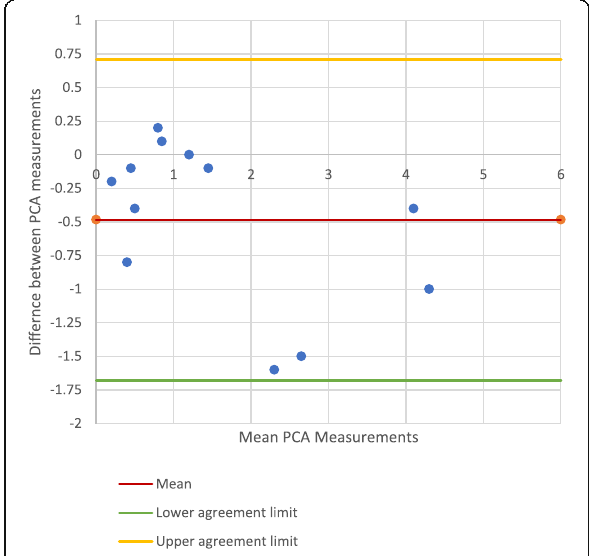
Fig. 4 PCA measurements on mechanical axis-photography vs . CT multi-slice